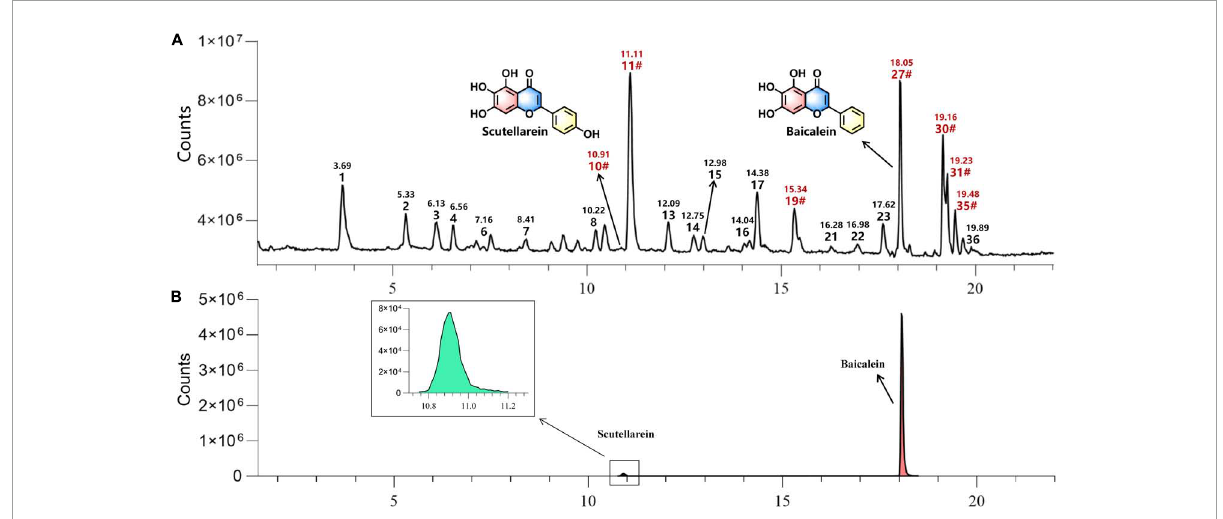
FIGURE6 The representative UHPLC-Q-TOF-MS chromatograms of extract of Scutellariae radix in negative mode The label of “#” indicated that compounds were confirmed by reference standards with indicated retention time. (A) Typical total ion chromatogram (TIC) of Scutellariae radix extract. (B) Typical extracted ion chromatogram (EIC) of scutellarein and baicalein in the extract of Scutellariae radix .